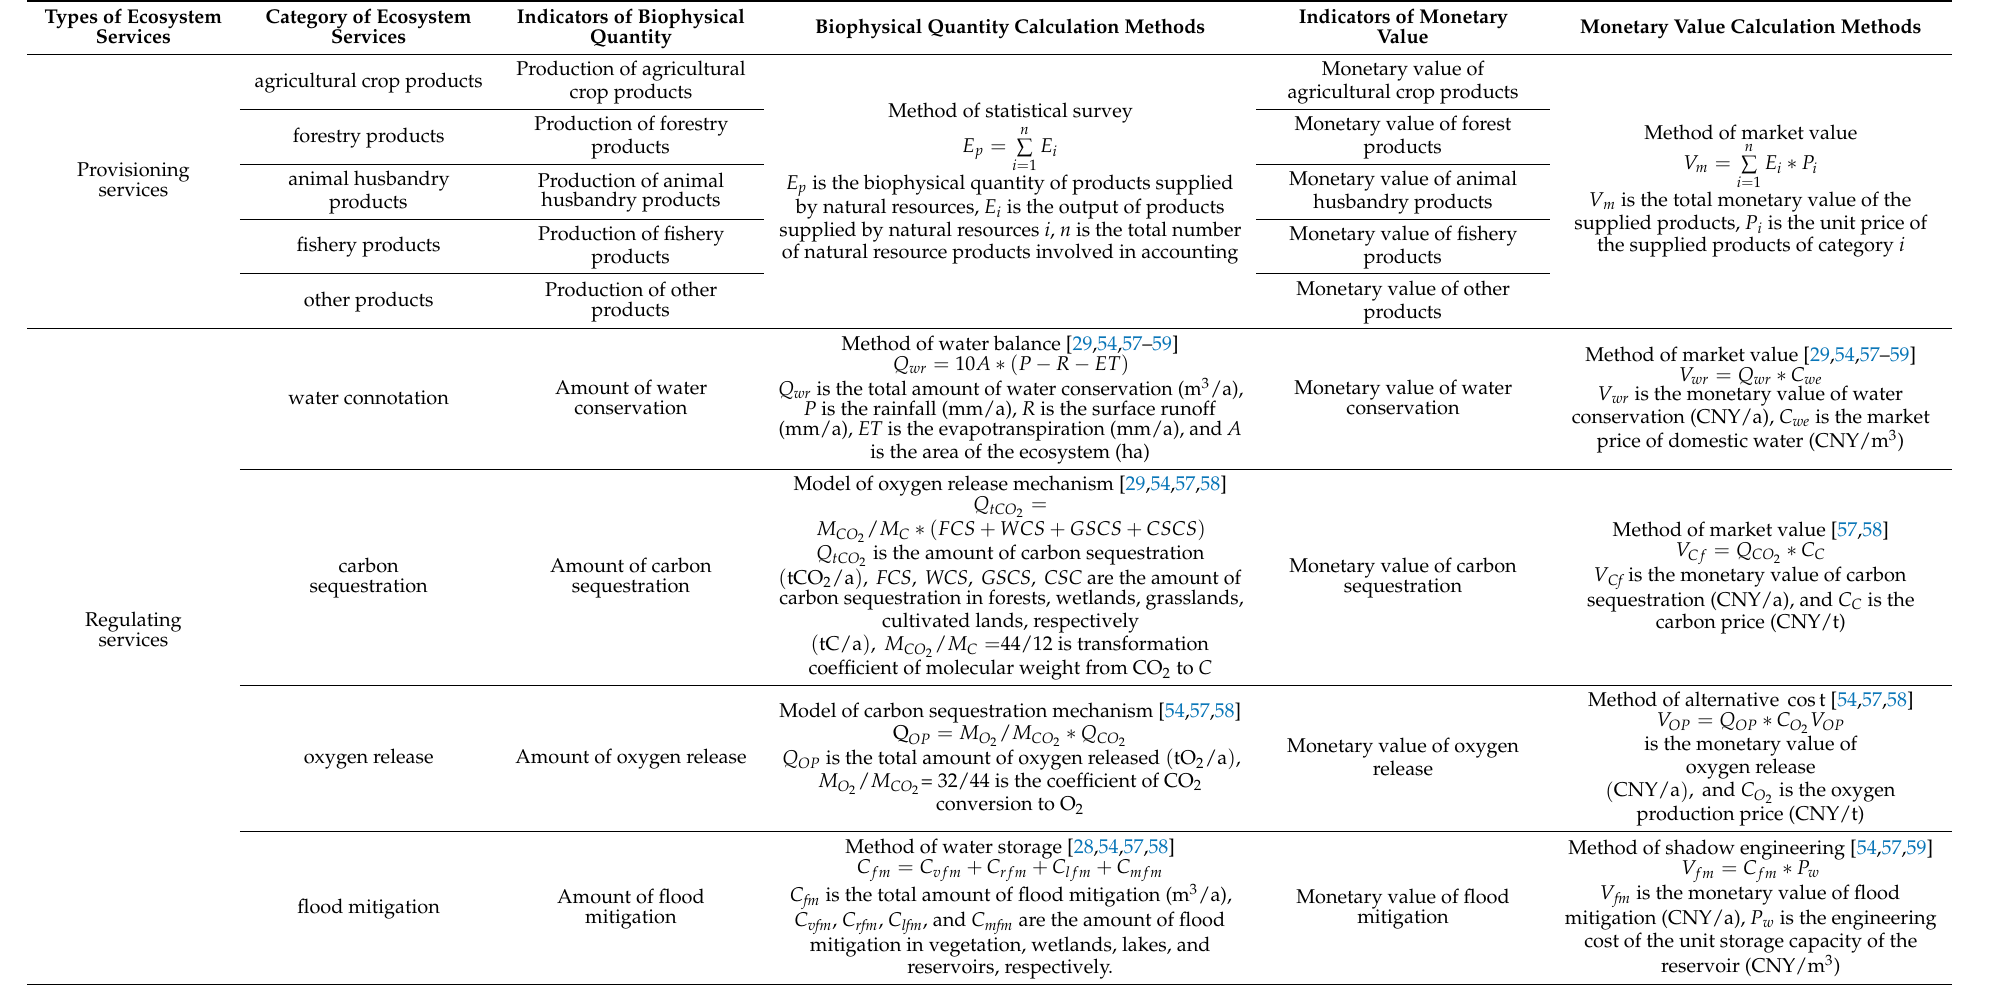
Table 3. A framework for accounting for the value of ecological products (natural resource assets) in rural